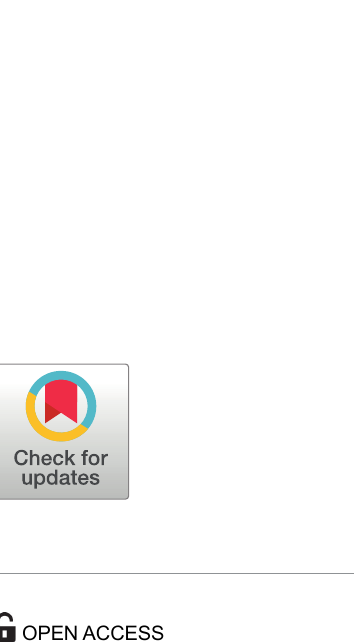
figshare.18134096 as described in the legend of Fig 4.)for cell